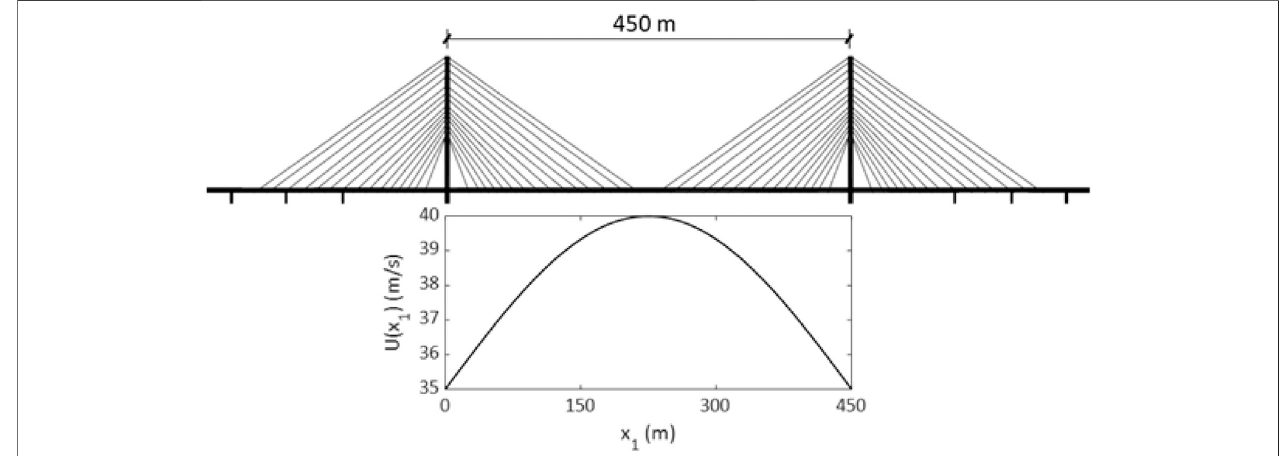
FIGURE 1| Spanwise fl uctuating alongwind:for bridge deck: (A) illustrates the dimension ofthe main span of abridge, and (B) shows the mean wind pro fi le along the bridge deck.